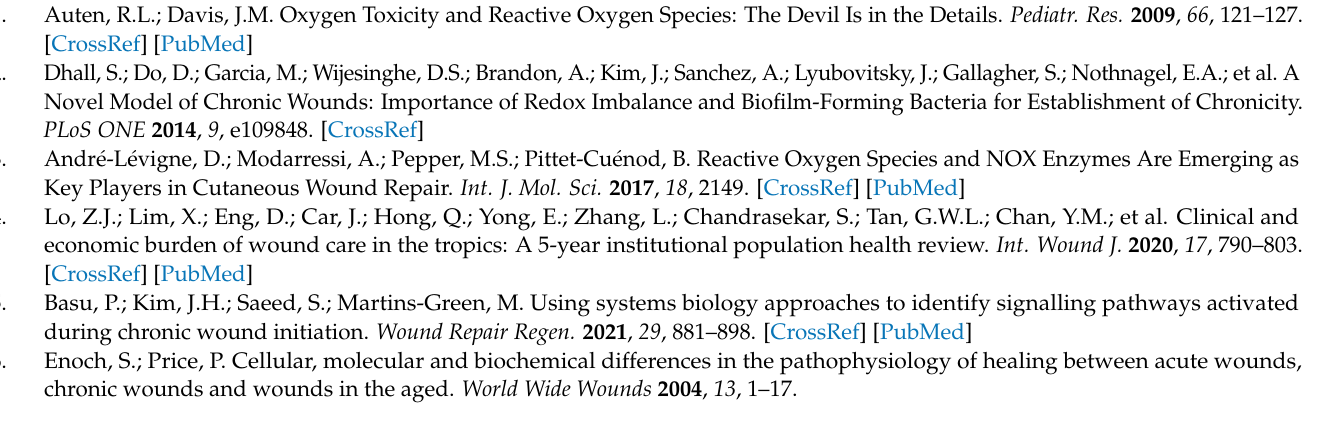
chronicity. Table S4. Genes in turquoise module significantly correlated to early chronicity. Table S5. Genes in brown module significantly correlated to early chronicity. Table S6. Genes in grey60 module significantly correlated to full chronicity (Day20 vs. Day1). Table S7. Genes in grey60 module significantly correlated to full chronicity (Day20 vs. Day5). Table S8. Genes in grey60 module significantly correlated to full chronicity (Day20 vs.